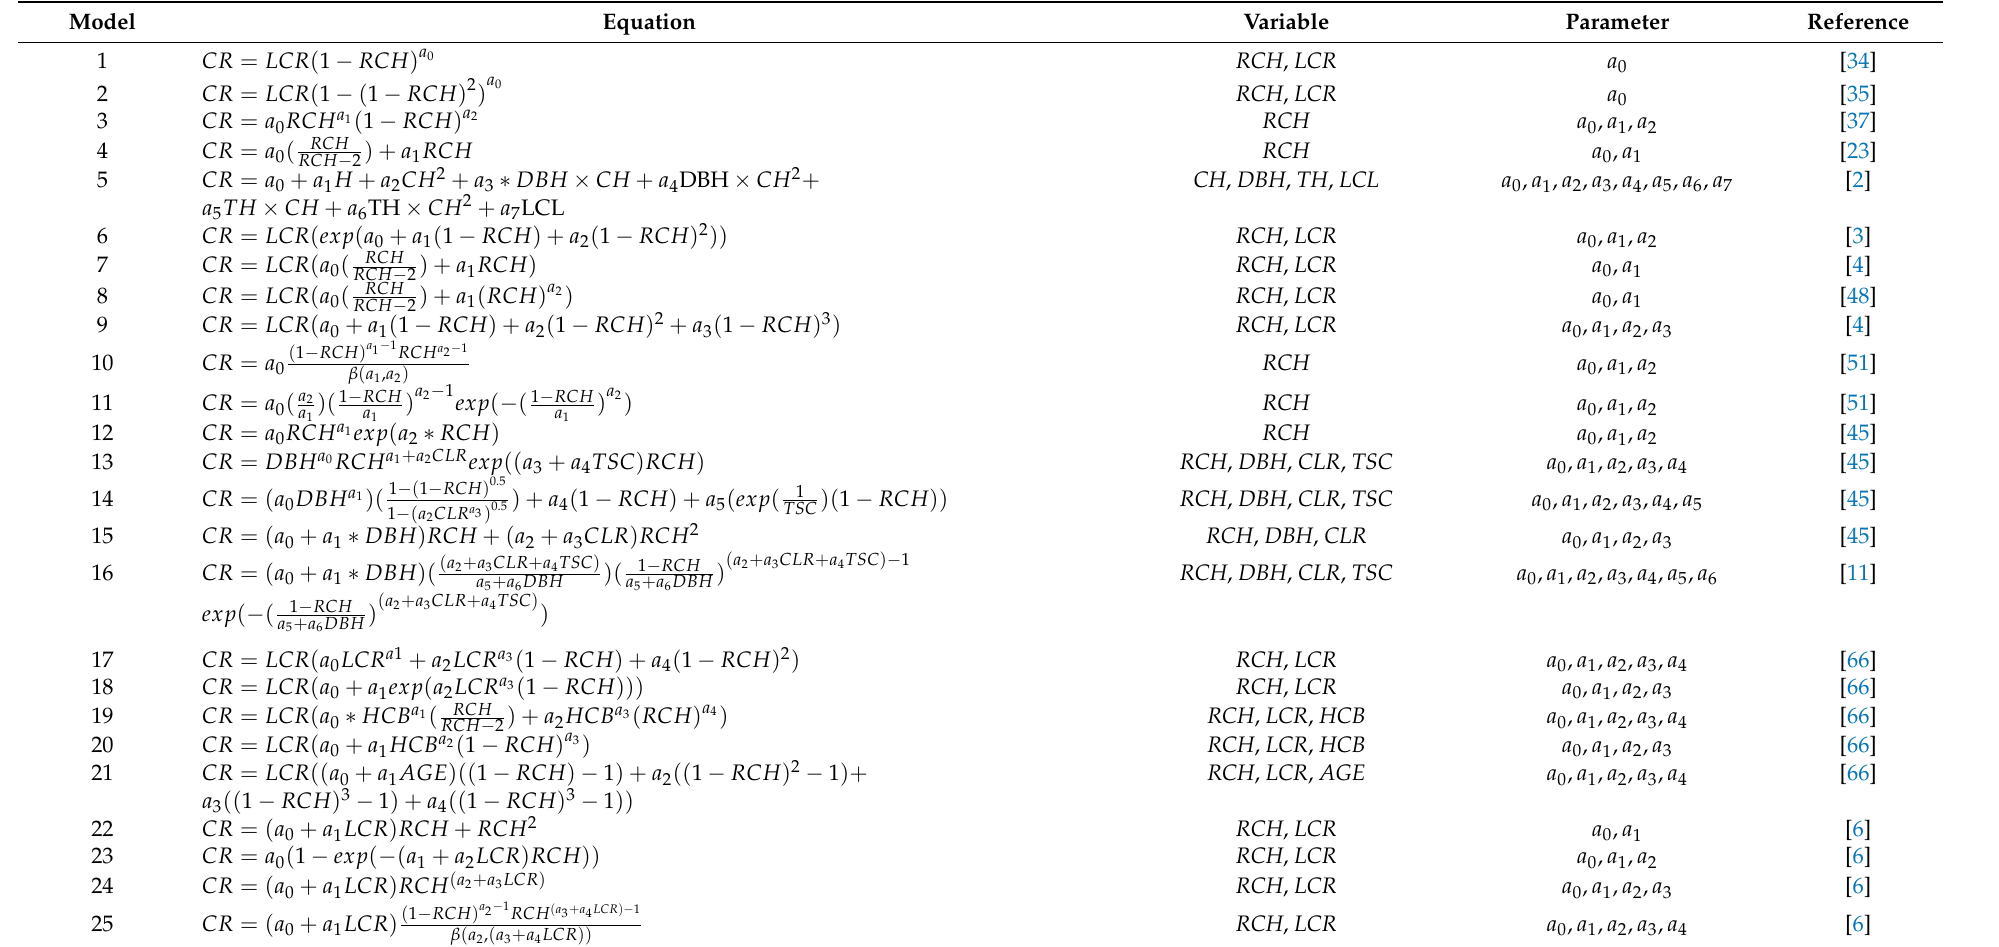
Table 2. Crown profile